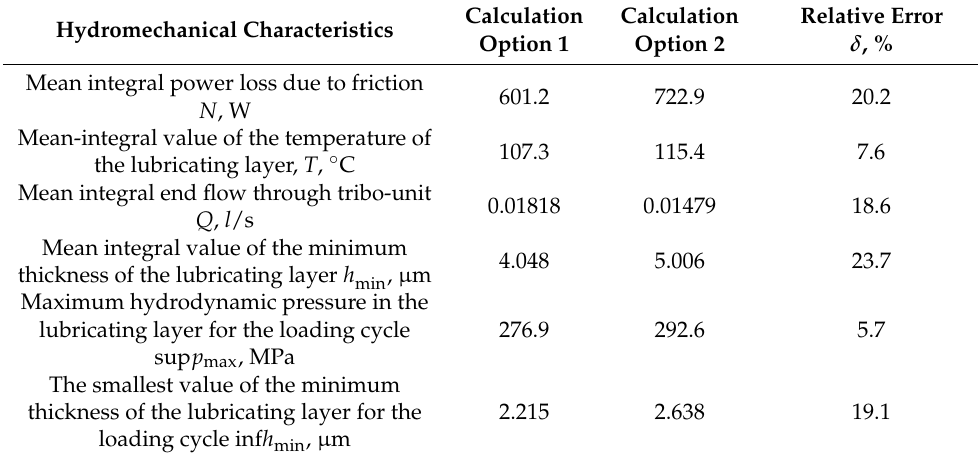
Table 3. Evaluation of the influence of a high-viscosity boundary layer on the hydromechanical characteristics of heavily loaded